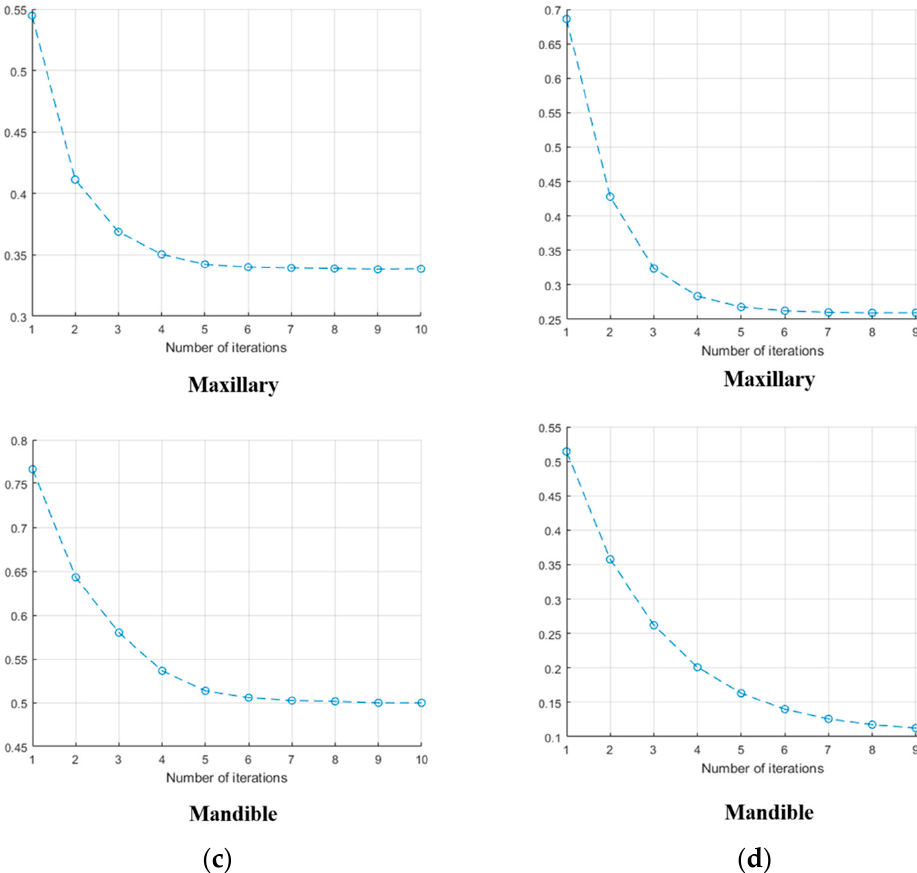
Figure 10. Average point distance of the modified iterative closest point (MICP) result. ( a ) set no.1; ( b ) set no.2; ( c ) set no.3; ( d ) set no.4 .